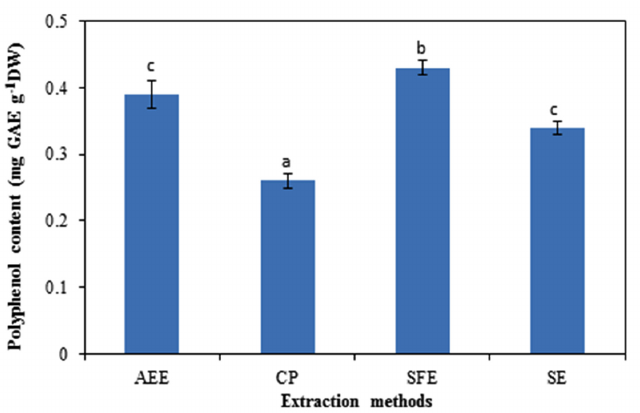
Fig. 1: Polyphenol content of A. pedunculatus seed oil obtained by different extraction methods [results with standard deviations shown by same letters (a-c) are not significantly different (p <